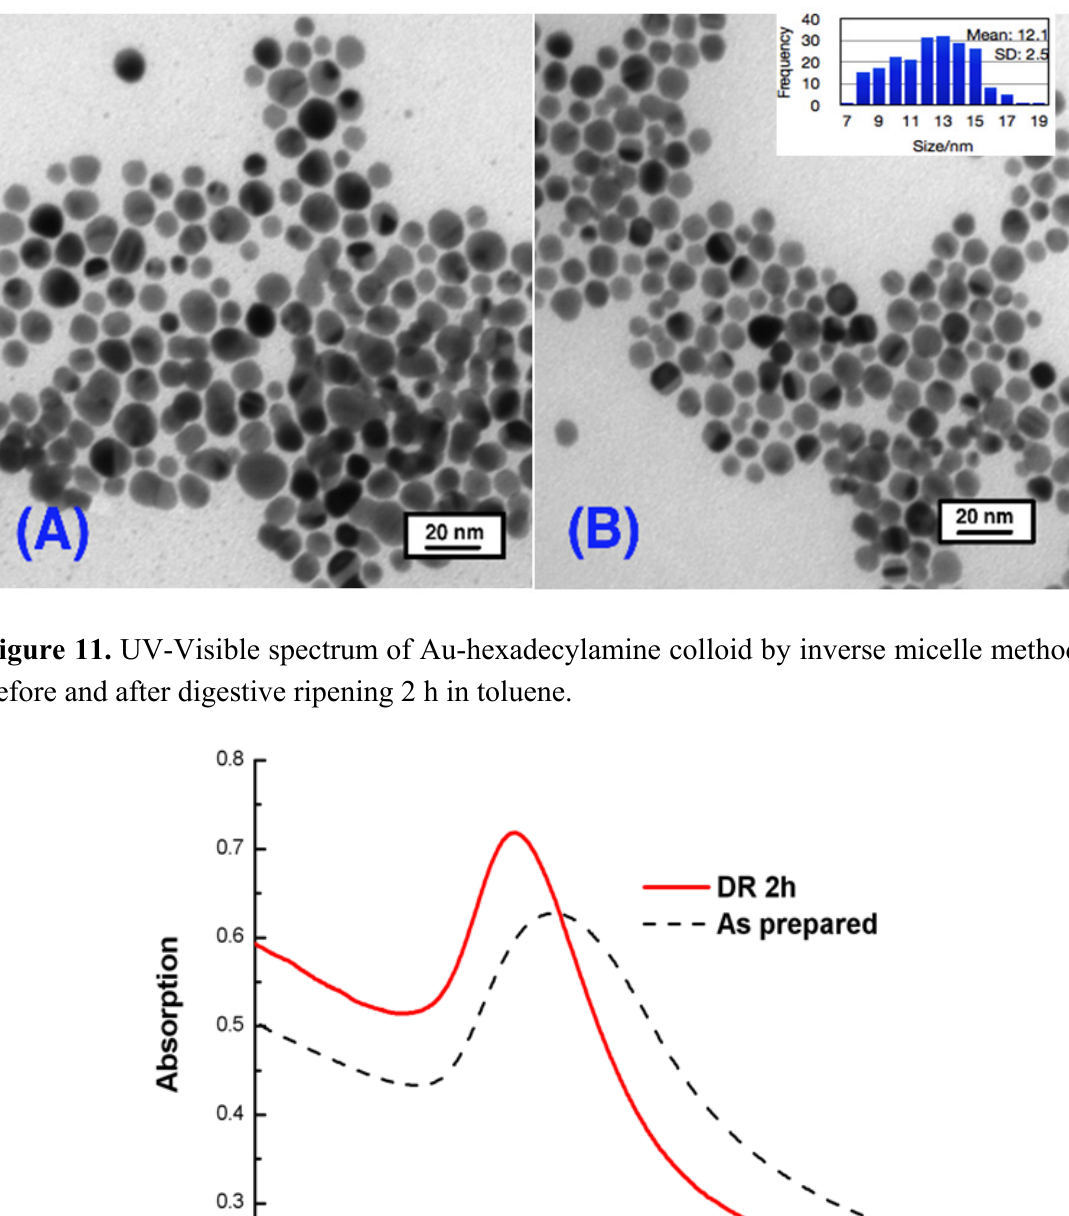
Figure 10. TEM images of ( A ) as prepared Au-hexadecylamine colloid by inverse micelle method in toluene; ( B ) Au-hexadecylamine colloid after digestive ripening 2 h in toluene.